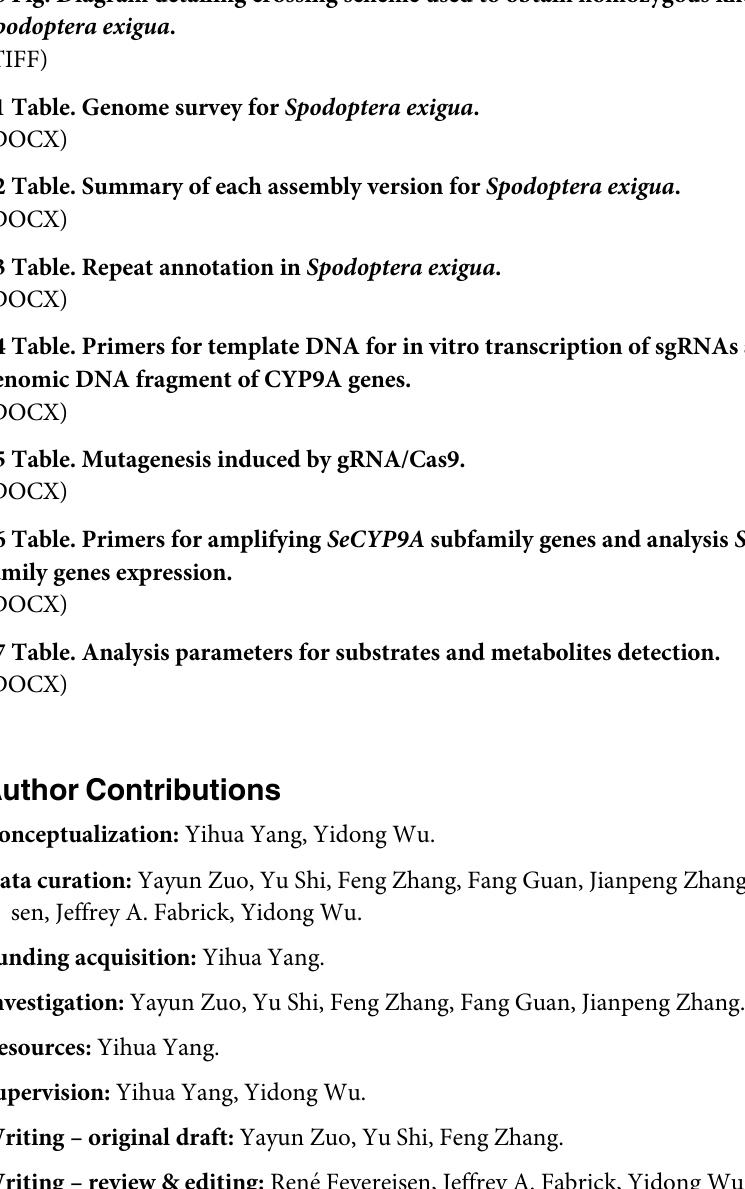
S8 Fig. Diagram detailing crossing scheme used to obtain homozygous knockout strains of Spodoptera exigua . S1 Table. Genome survey for Spodoptera exigua . S2 Table. Summary of each assembly version for Spodoptera exigua . S3 Table. Repeat annotation in Spodoptera exigua . S4 Table. Primers for template DNA for in vitro transcription of sgRNAs and amplifying genomic DNA fragment of CYP9A genes. S5 Table. Mutagenesis induced by gRNA/Cas9. S6 Table. Primers for amplifying SeCYP9A subfamily genes and analysis SeCYP9A sub- family genes expression. S7 Table. Analysis parameters for substrates and metabolites